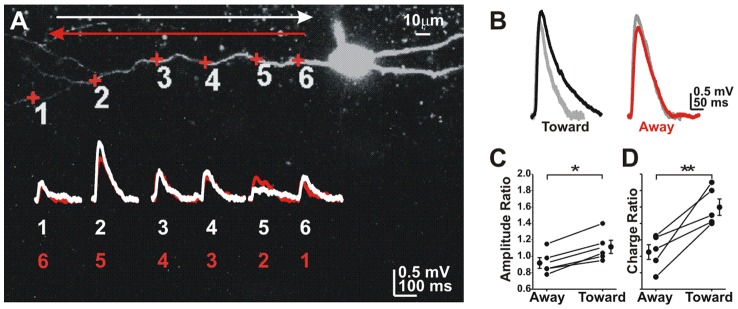
Cortical neurons favor centripetal summation.
A) A hippocampal oriens lacunosum moleculare cell with uncaging locations (+) and EPSPs (average of 5 trials) for each location moving toward or away from the soma. B) Expected (calculated) charge for multiple activation (grey) vs. actual summed EPSP. C) Summation ratio for peak amplitude. D) Summation ratio for total charge. (* paired t-test; p<0.05 N = 6 cells; ** p<0.025; N = 5 cells).